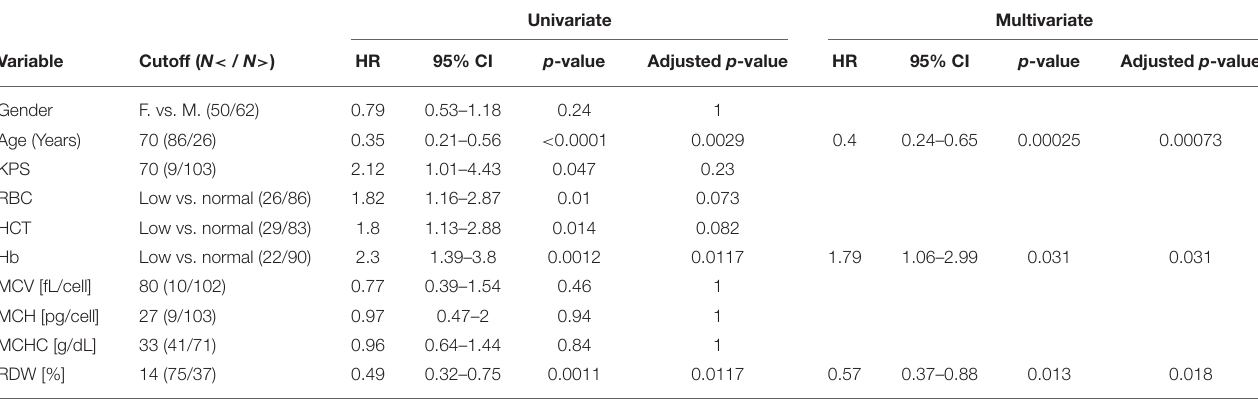
TABLE 3 | Univariate and multivariate analysis of the 112 treated GBM patients’